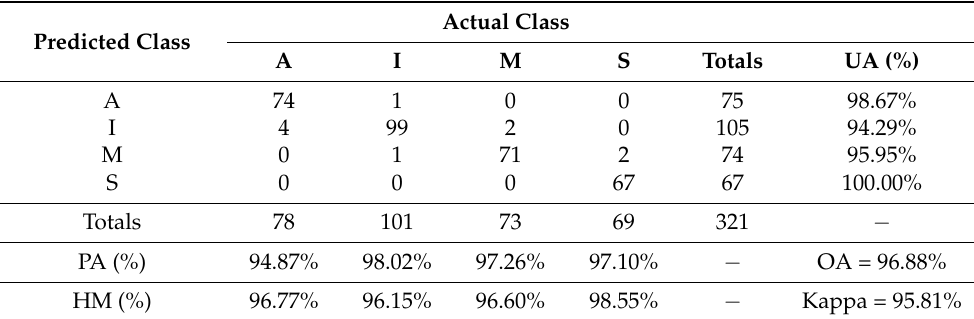
Table 6. Confusion matrix for detecting disease severity based on an SVM. Predicted